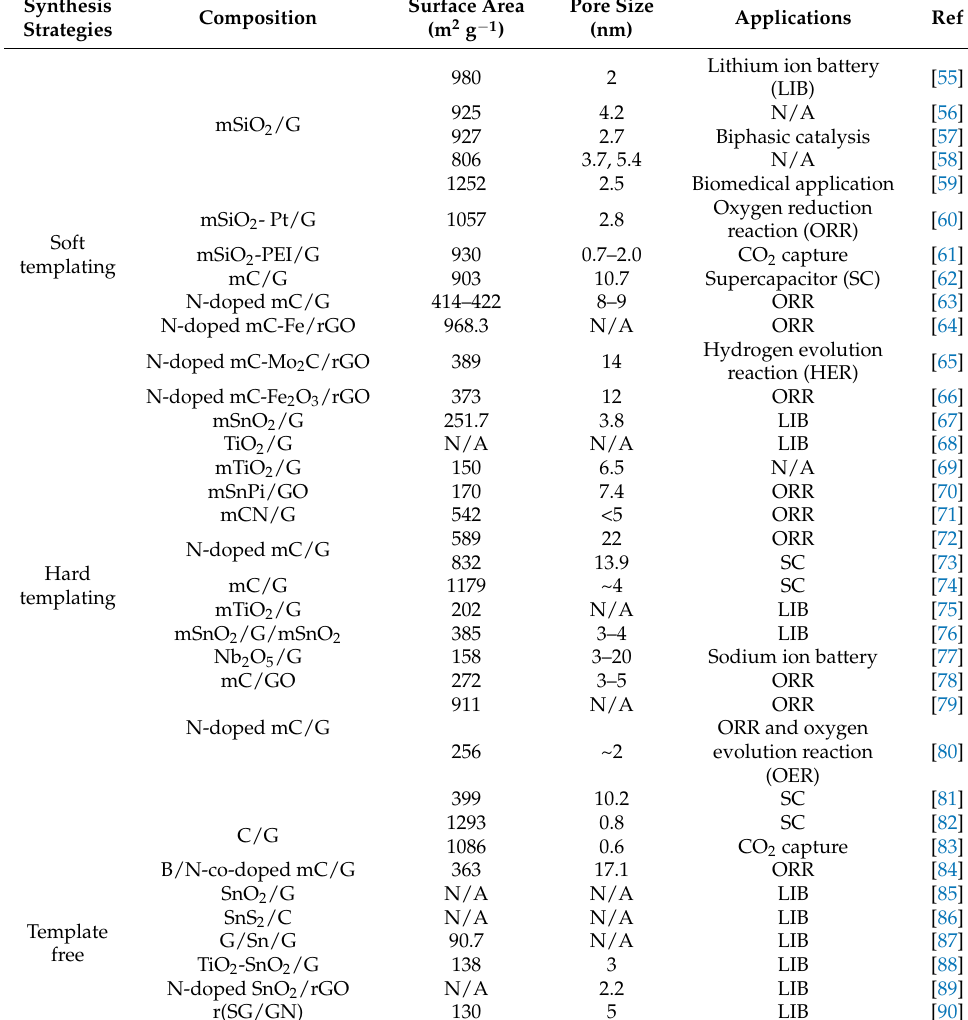
Table 1. Summary of graphene-based two-dimensional (2D) mesoporous materials. Synthesis